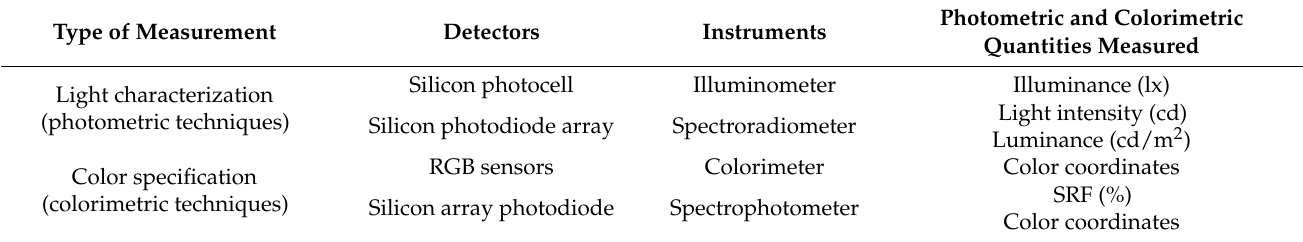
Table 1. Type of measurements, detectors, instruments and measured photometric and colorimetric